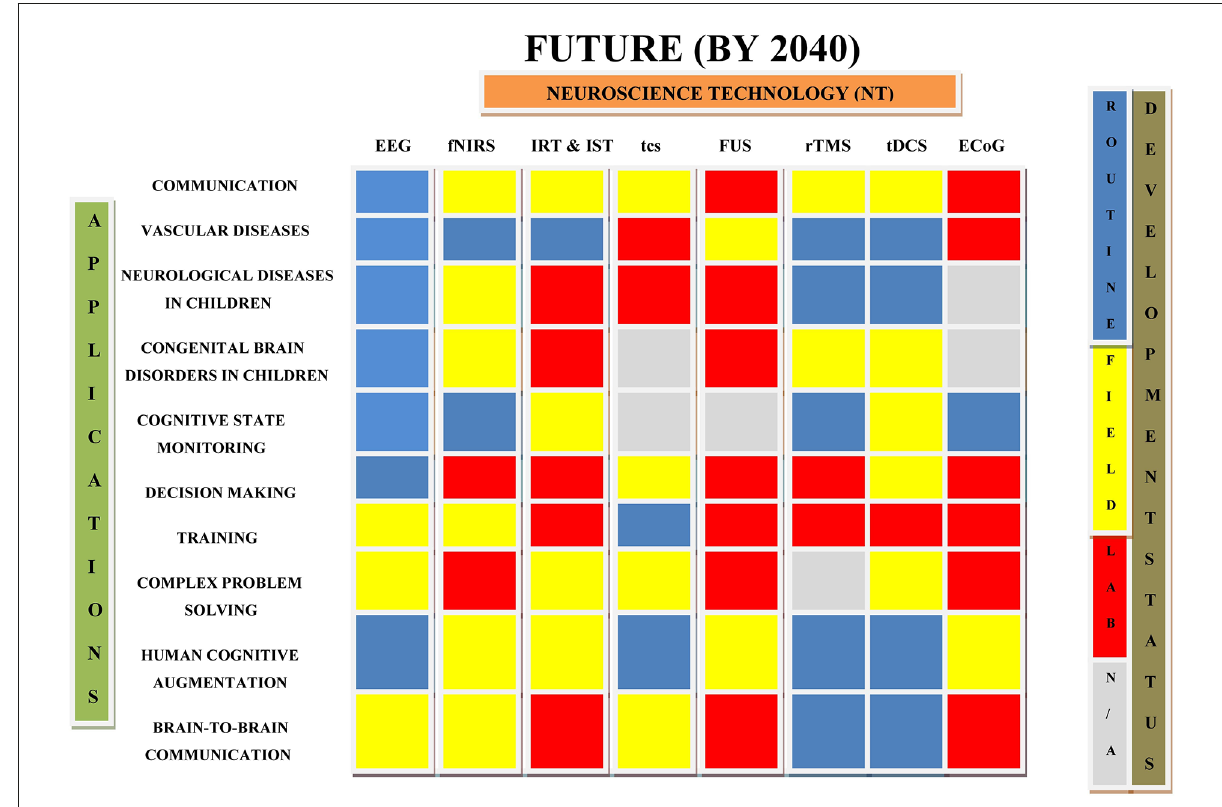
FIGURE4 Future prospects of neuroscience technologies. The picture highlights future development and applications of neuroscience technologies for different medical and non-medical purposes (Cinel et al.,